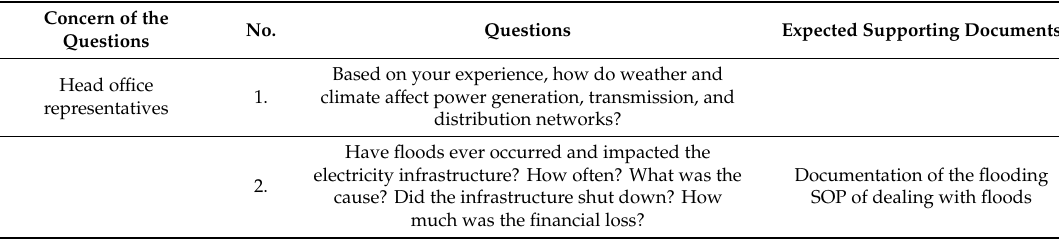
Table A2. Questions presented to di ff erent